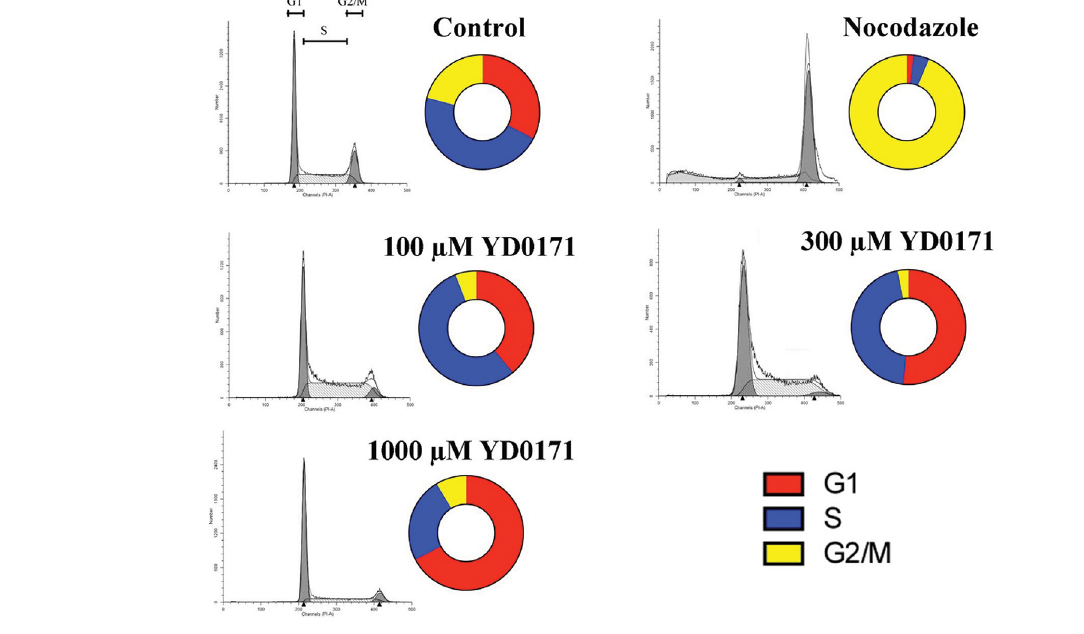
Figure 10 . Effect of YD0171 on the cell cycle of HCT116 cells. Cells were treated with YD0171 (100, 300, 1 mmol/L), or the positive control nocodazole for 48 h, followed by flow cytometric cell cycle analysis. Typical profiles are shown in the gray panels; cell cycle distributions are shown by the bagel charts. Although nocodazole induced the expected G1 cell cycle arrest, YD0171 or AOAA did not induce cell cycle arrest but increased the G1 phase and reduced the G2 phase. Data shown are representative of n = 3 determinations.